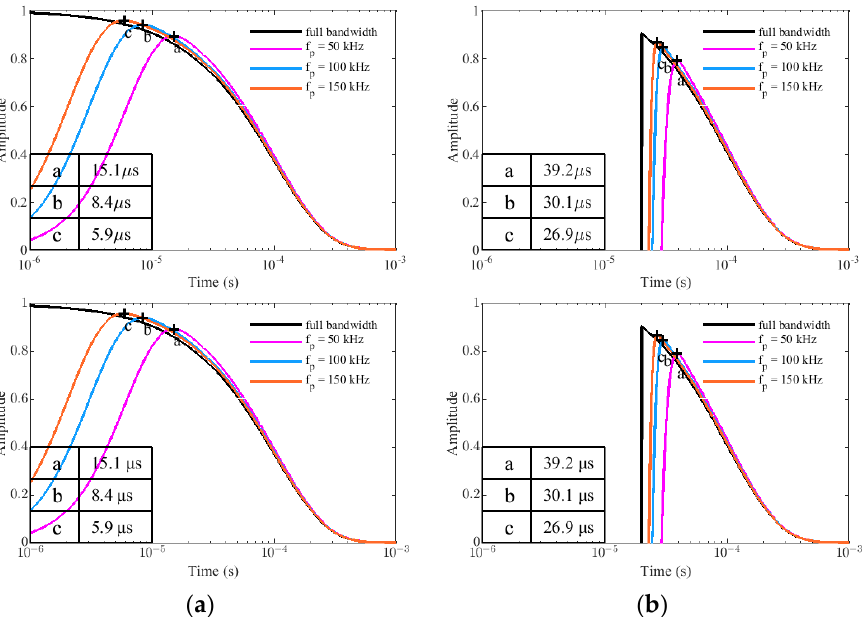
Figure 8. The simulation results in different resonant frequencies w p : ( a ) the target response of PRBS method G p (t). ( b ) the target response of traditional method G t (t).